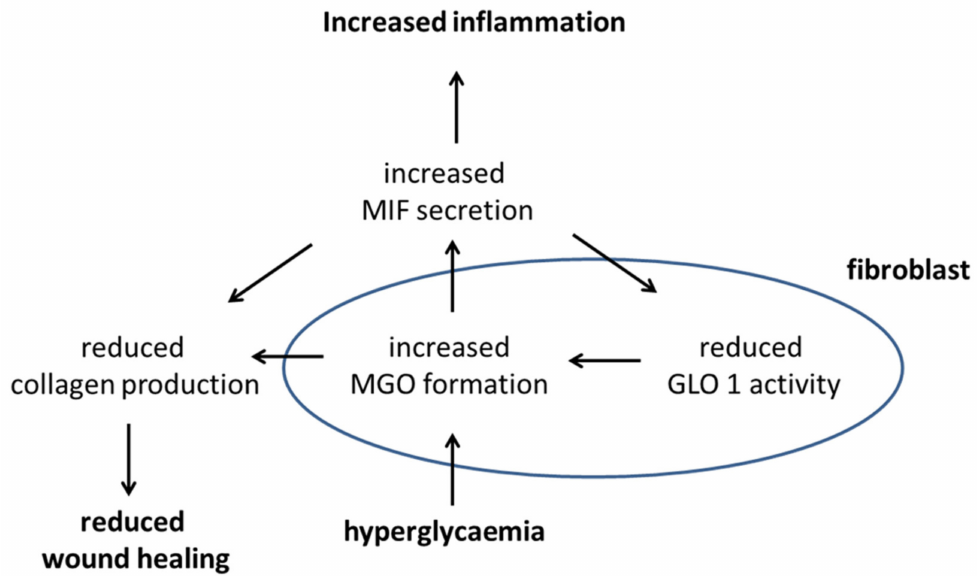
Figure 5. Putative signalling pathway under hyperglycaemic conditions on how hyperglycemia affects wound healing and